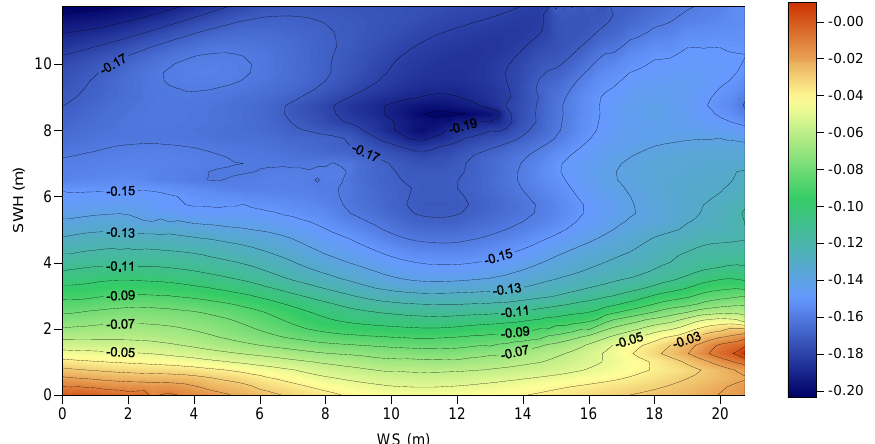
Figure 11b – Labroue SSB model for TOPEX A (metres).